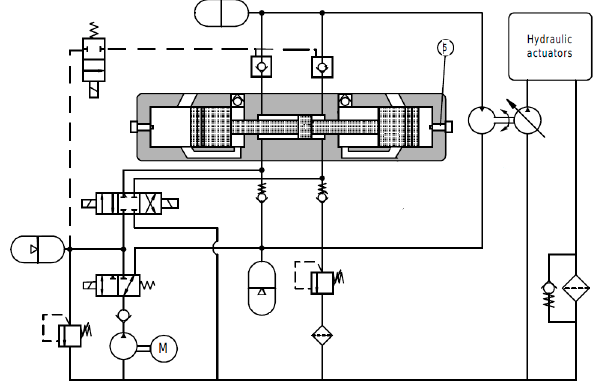
Figure 5. The Tampere University of Technology HFPE [14].